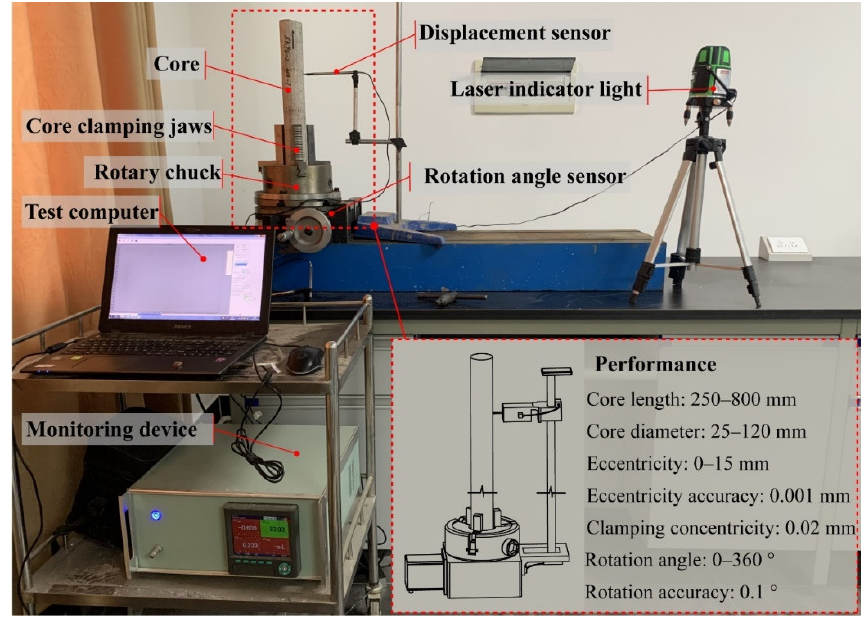
Figure 4. Projection of circle O′ on the plane of circle O.